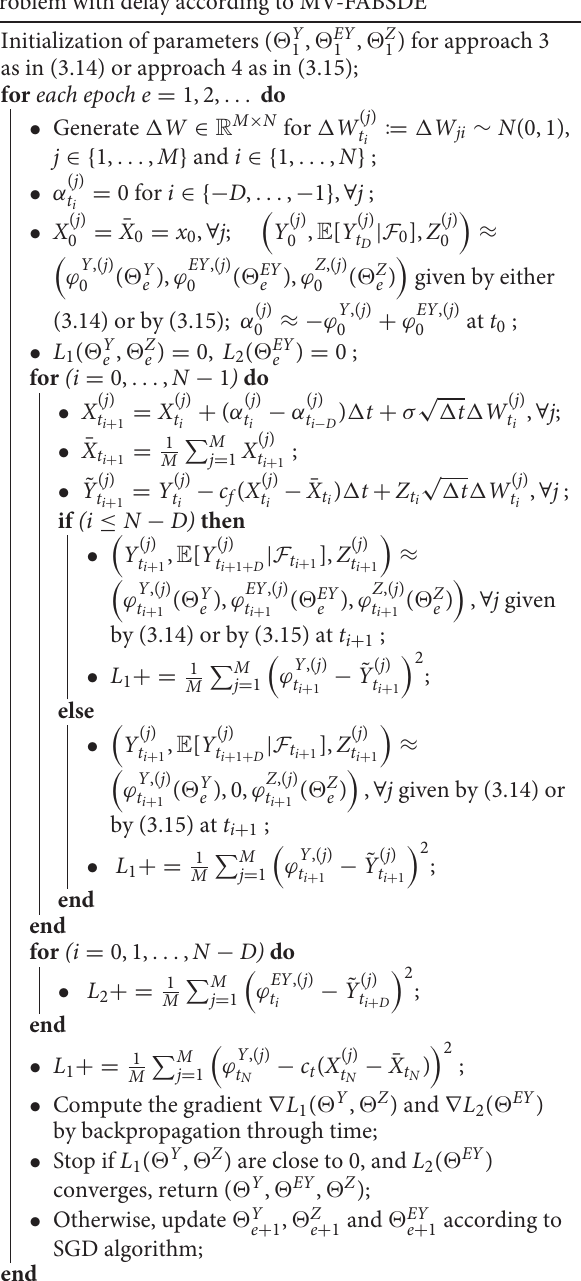
, 2 EY , 2 Z ) for approach 3 1 1 1